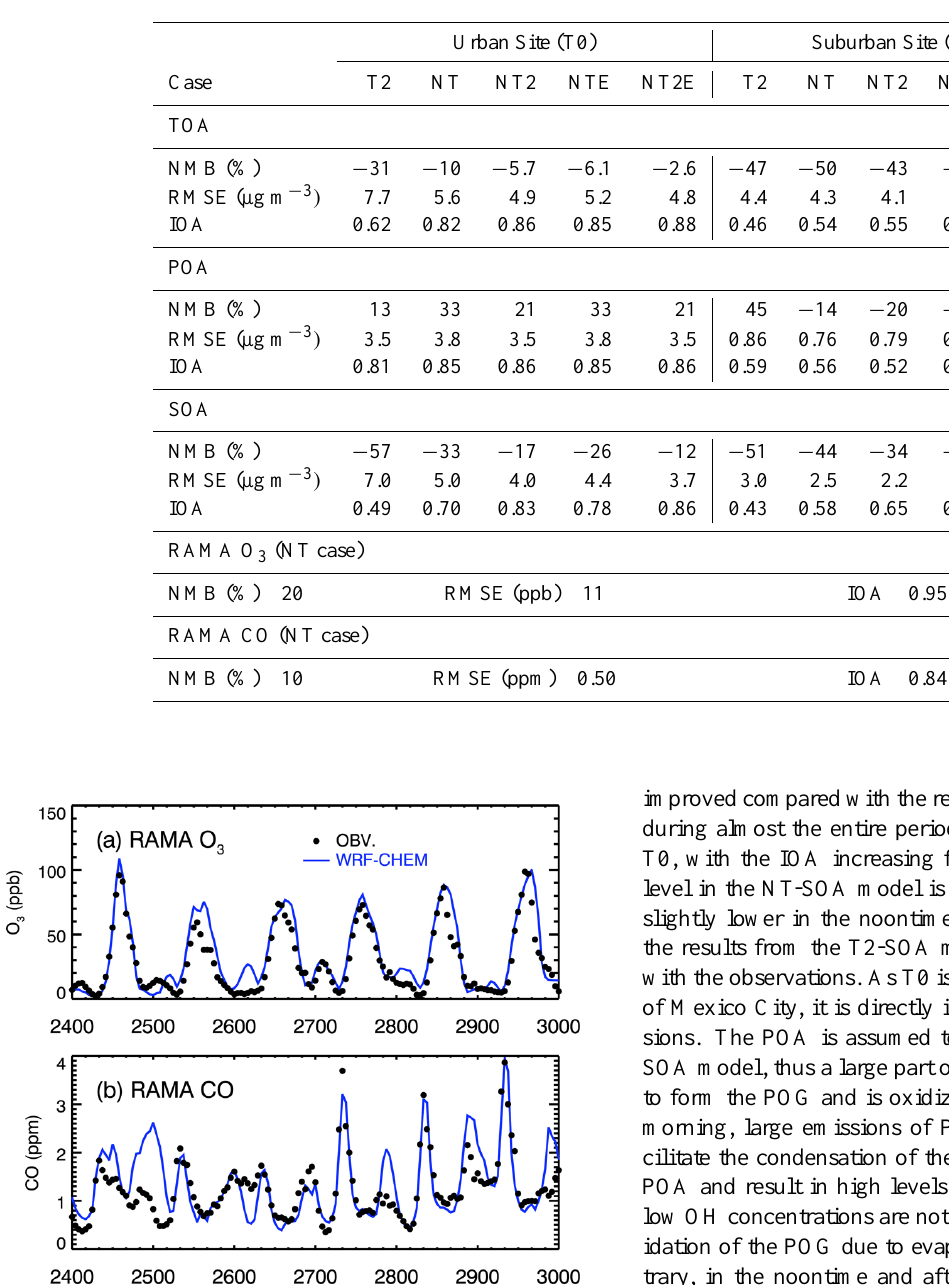
Table 1. Statistical comparison of simulated and measured OA concentrations at T0 and T1 and O 3 and CO concentrations at RAMA monitoring sites during the period 24 to 29 March 2006.